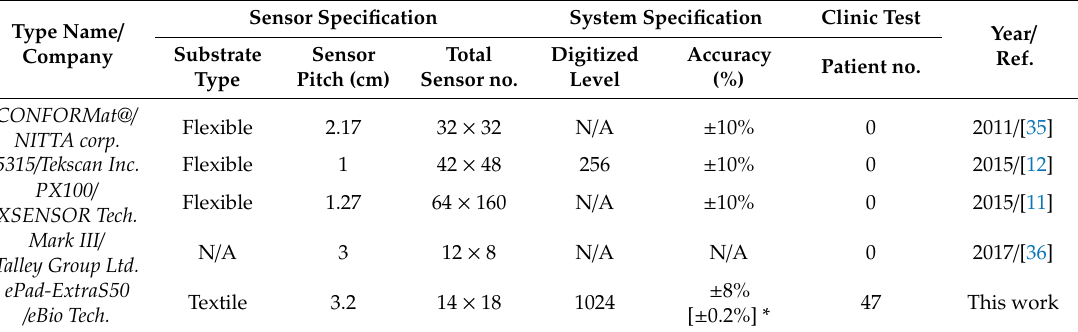
Table 3. Comparison of pressure sensing systems.